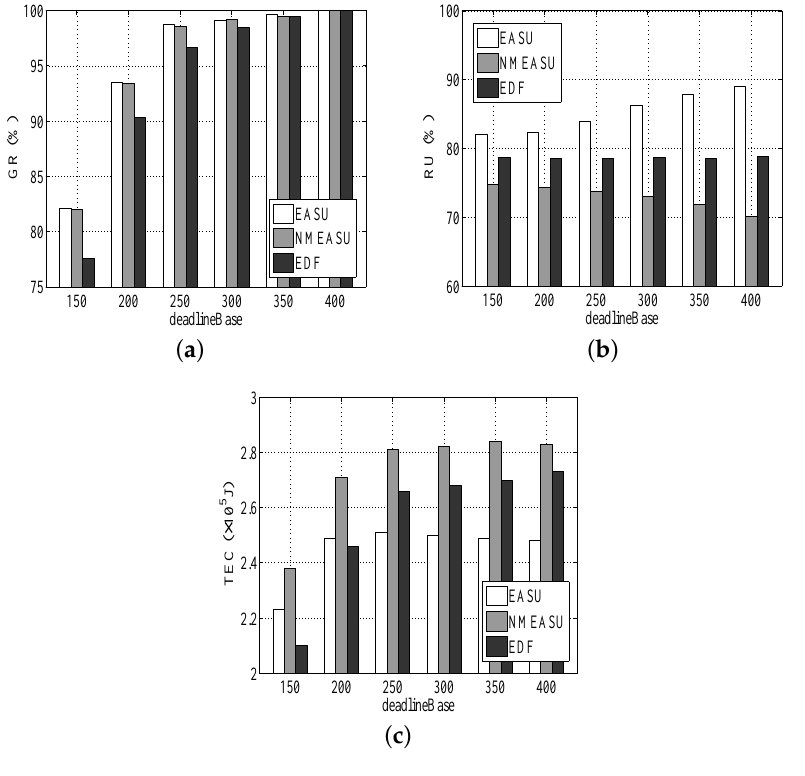
Figure 3. Performance impacts of task deadlines. ( a ) Impact of deadlineBase on GR, ( b ) Impact of deadlineBase on RU, ( c ) Impact of deadlineBase on